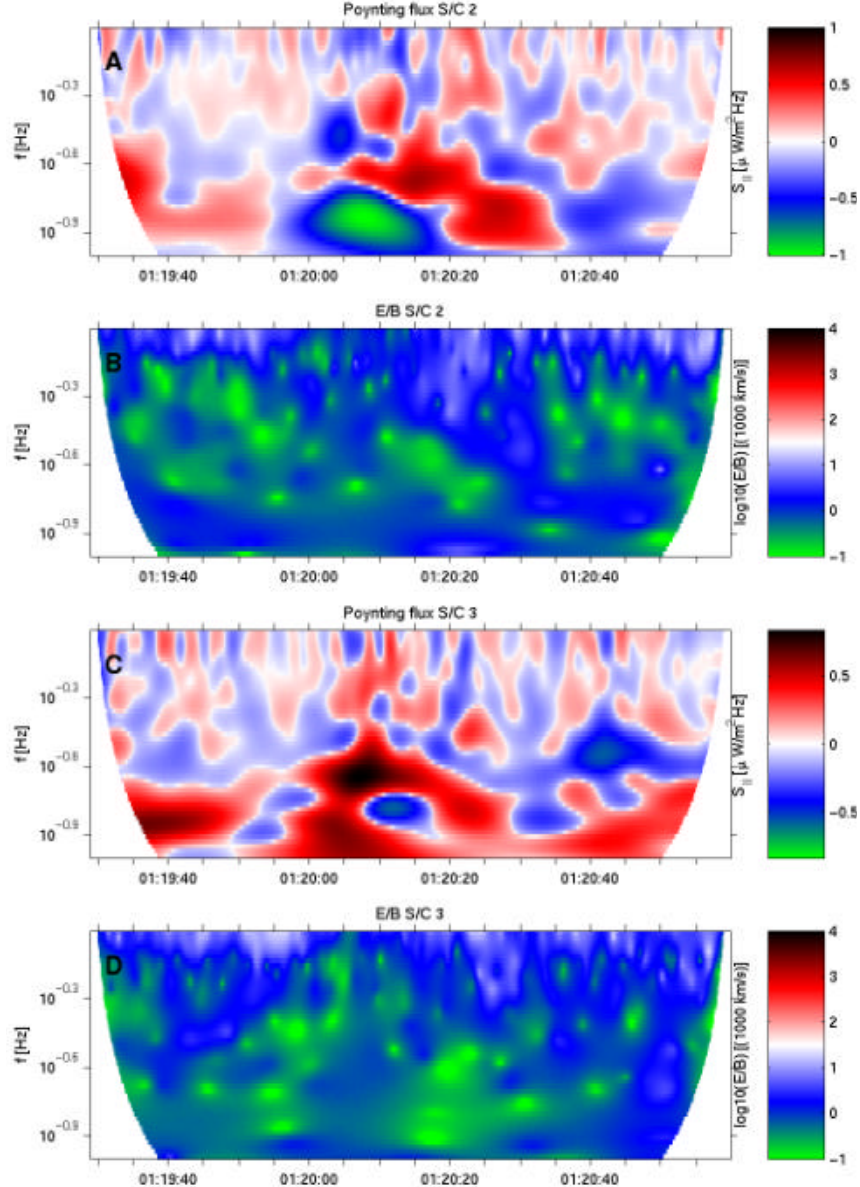
Fig. 9. Morelet wavelet analyses of the Poynting flux from Cluster satellites 2 and 3 (panels 1 and 3), where red (green) indicates downward (upward) flux, and the corresponding ratio of the electric and magnetic fields (panels 2 and 4). These results are obtained from data in panels (C) and (D) in Figs. 1 and 2. The observations indicate a mixture of downgoing and upgoing Alfv´en